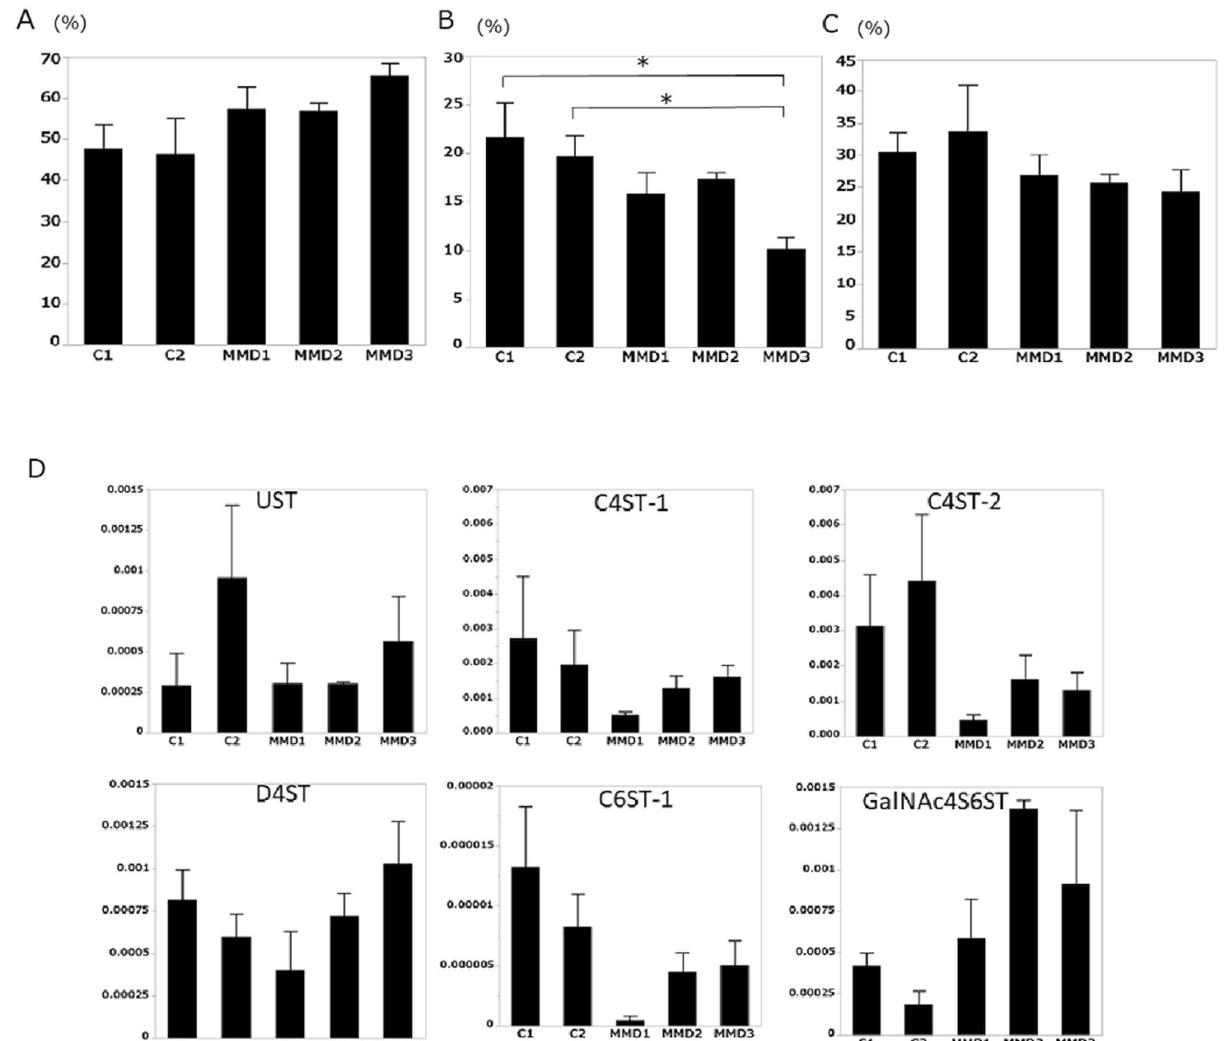
Figure 5. ( A ) Low sulfated CS ratio to total CS for each iPSEC sample. ( B ) CS-C6 ratio to total CS for each iPSEC sample. MMD3 showed a significantly lower ratio of CS-C6, compared with Control 1 or 2 (* P < 0.05). ( C ) CS-C4 ratio to total CS for each iPSEC sample. ( D ) Expression of enzymes for CS sulfation. Although there was no statistical significance, C4ST1, C4ST2 and C6ST-1 tended to be downregulated in MMD. UST, uronyl 2- O -sulfotransferase; C4ST, chondroitin 4- O -sulfotransferase; D4ST, dermatan 4- O -sulfotransferase; C6ST, chondroitin 6- O -sulfotransferase; GalNAc4S-6ST, N -acetylgalactosamine 4-sulfate 6- O -sulfotransferase. Error bars are